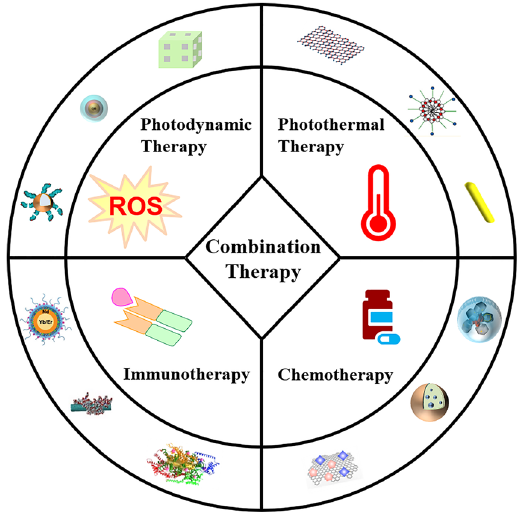
Figure 1: Schematic illustration of combination strategy with different monotherapies and corresponding examples.